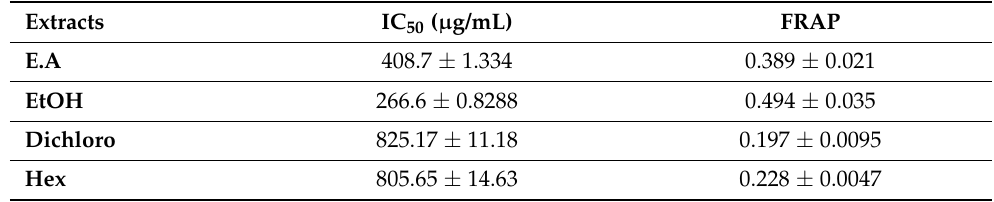
Table 2. Antioxidant effects of C. ladanifer